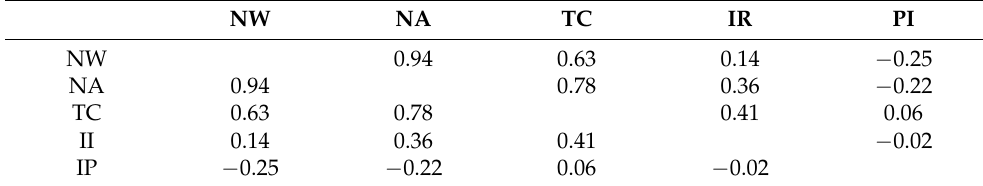
Table 4. Correlation between